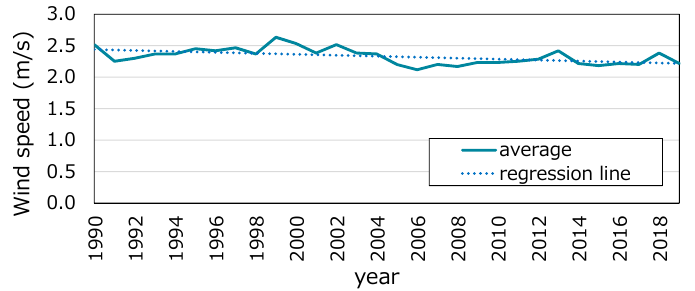
Figure 11. Trend in annual averages of wind speed. Wind speed: annual averages of hourly wind speed at six General sta. (Daishi, Nakahara, Takatsu, Miyamae, Tama, and Asao).